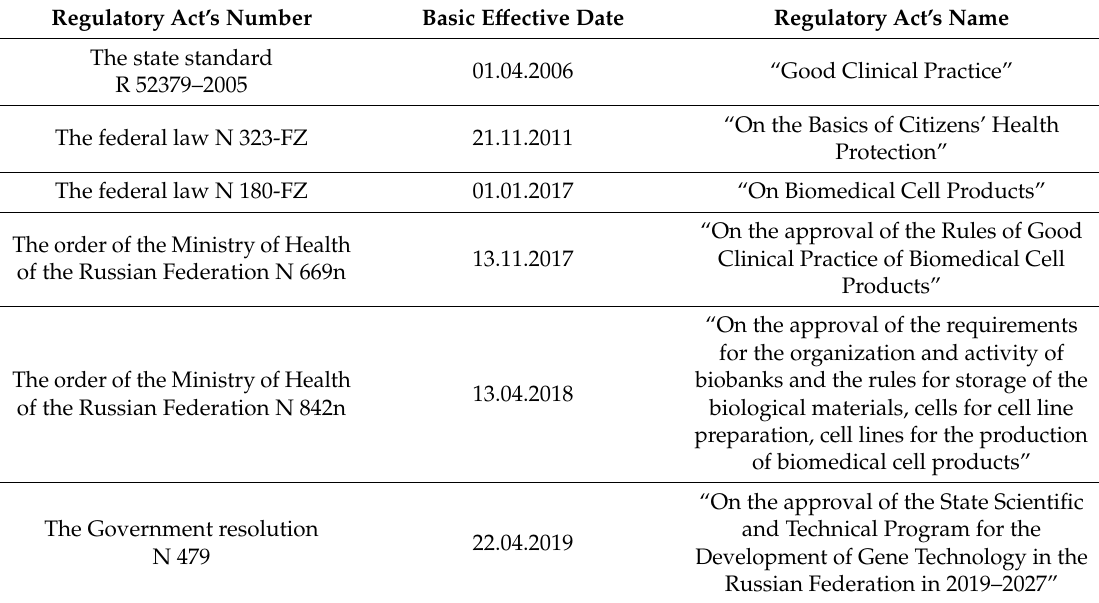
Table 4. Basic regulatory acts specifying development of regenerative medicine in Russia